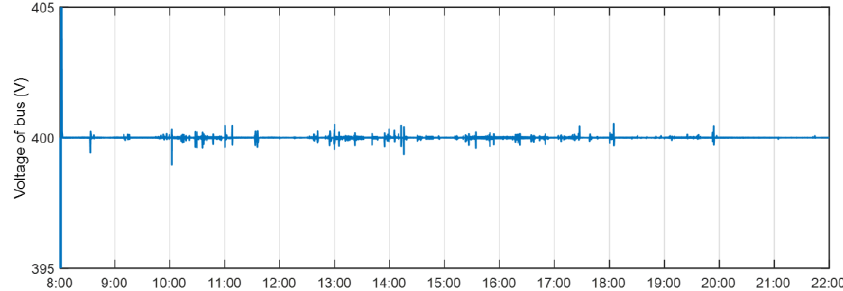
Figure 8. DC bus voltage evolution under ICDA.